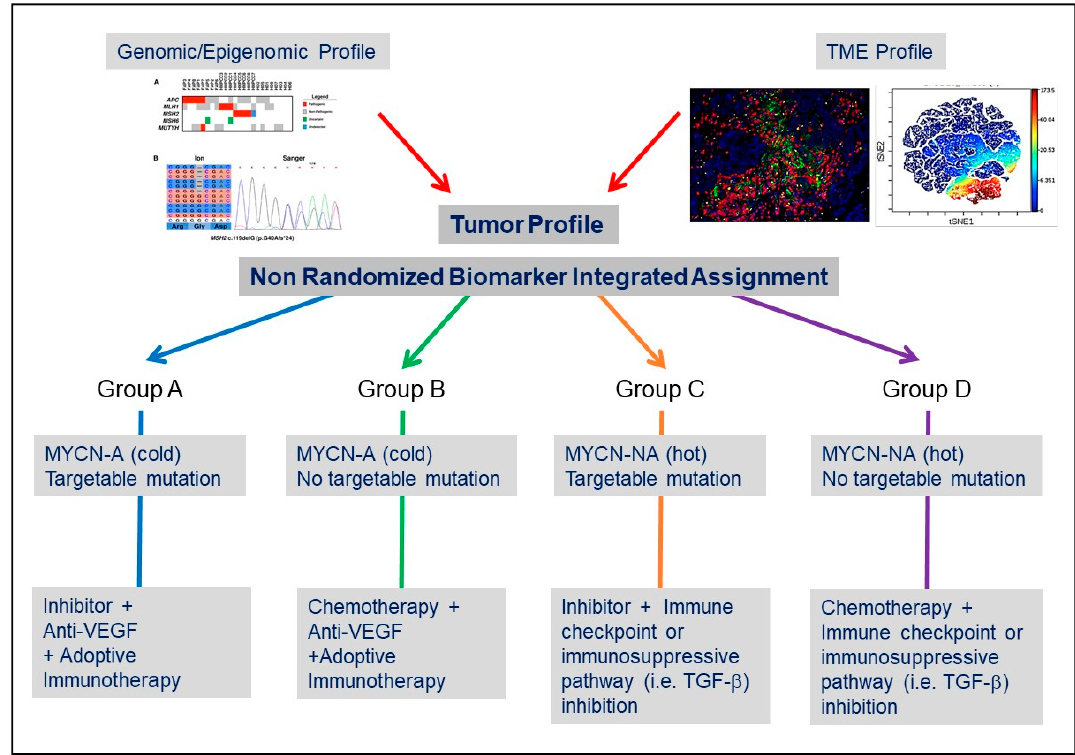
Figure 2. Considering the TME in the design of clinical trials in NB. Simplified conceptual design of a biomarker-integrated umbrella protocol in NB based on genomic and TME information.